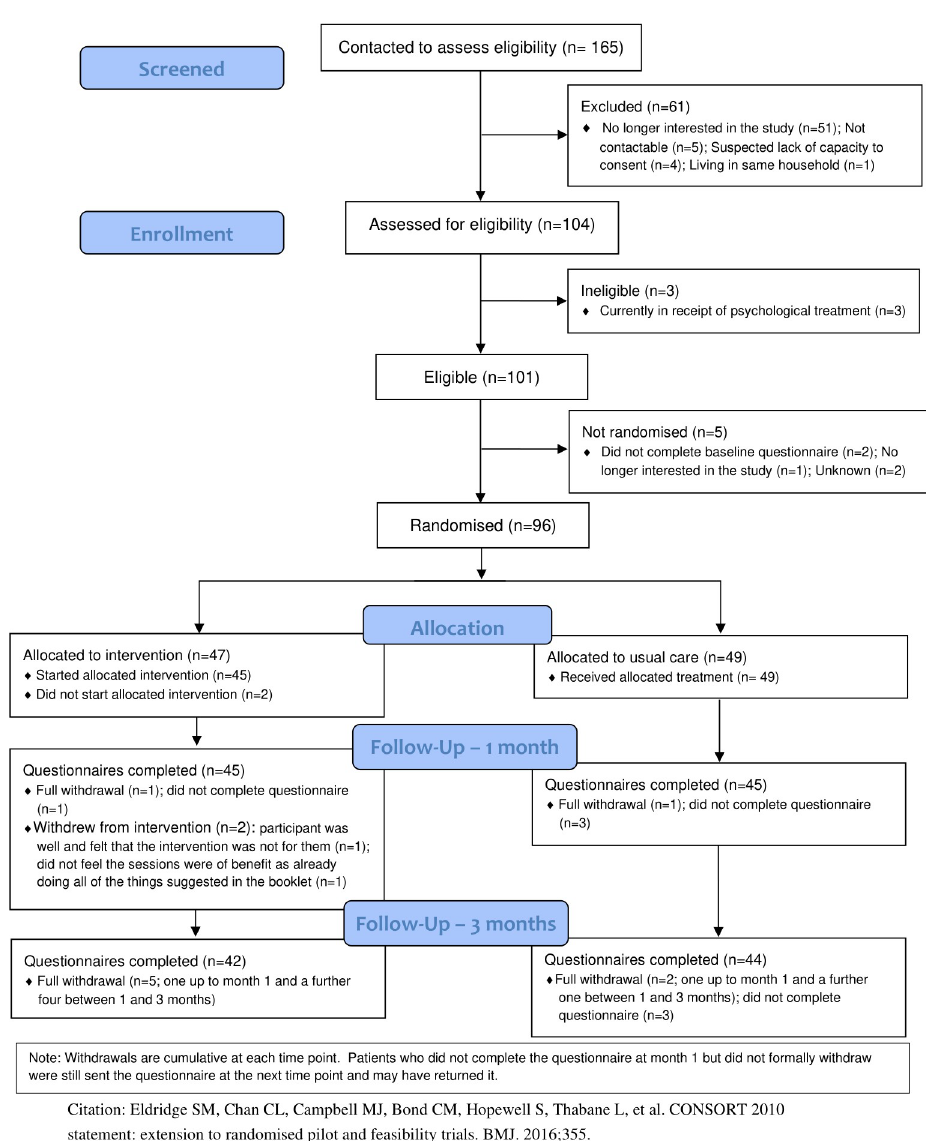
Fig 1. CONSORT flow